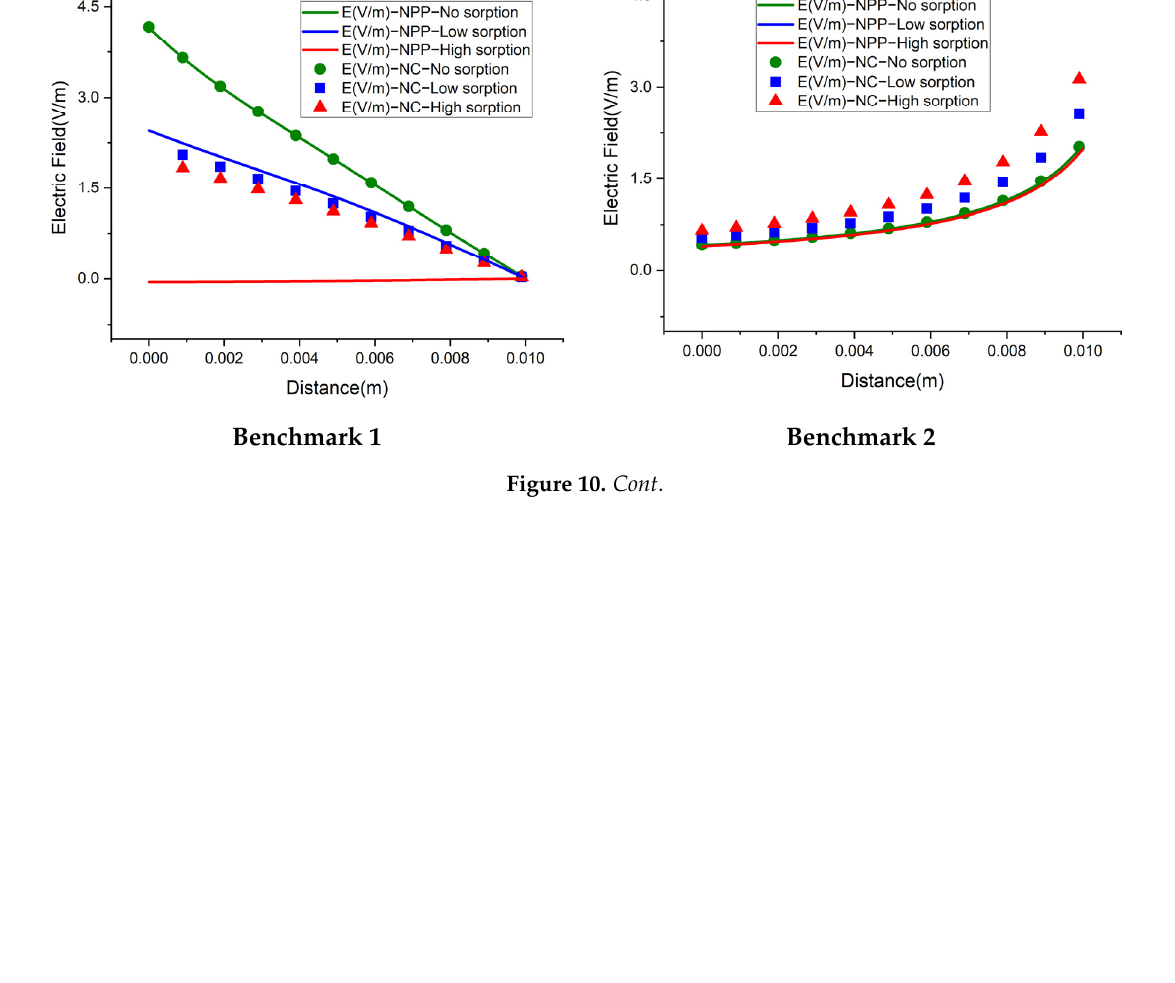
Figure 9. The total charge for the 2D benchmark with the NC-model: low sorptivity (test case 1), high sorptivity (test case 2).